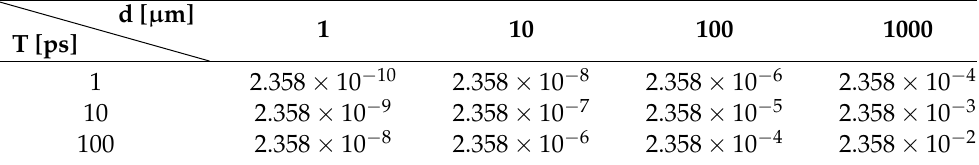
Figure 8. Left : Log ( η tot ) vs. T,d (E = 1 nJ); right : Log ( η tot ) vs. T,d (E = 100 nJ). Table 2. Pulse energy (J) to obtain φ = π in a Kerr cell (active medium: 1 mm of TiO 2 ) at 532